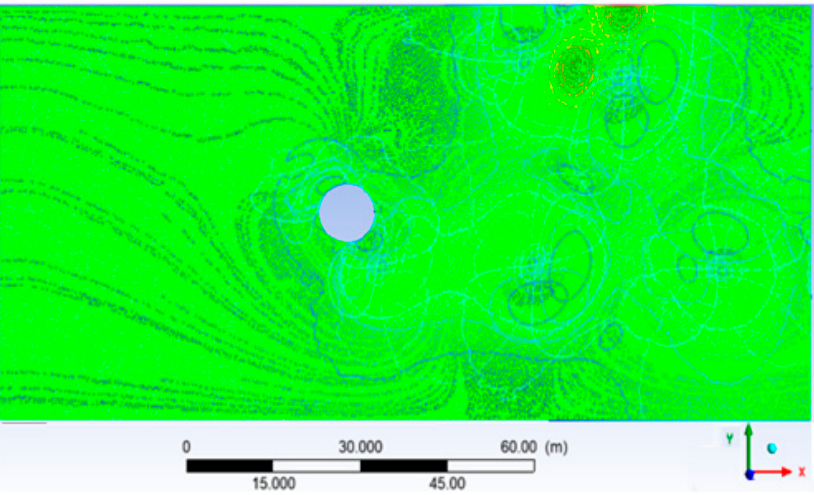
Figure 10. Velocity u Contour profile for Vortex effect around the CALM Buoy for ( a ) 0.45 m/s flow velocity with streamlines and ( b ) 1.5 m/s flow velocity without streamlines, in ANSYS Fluent.